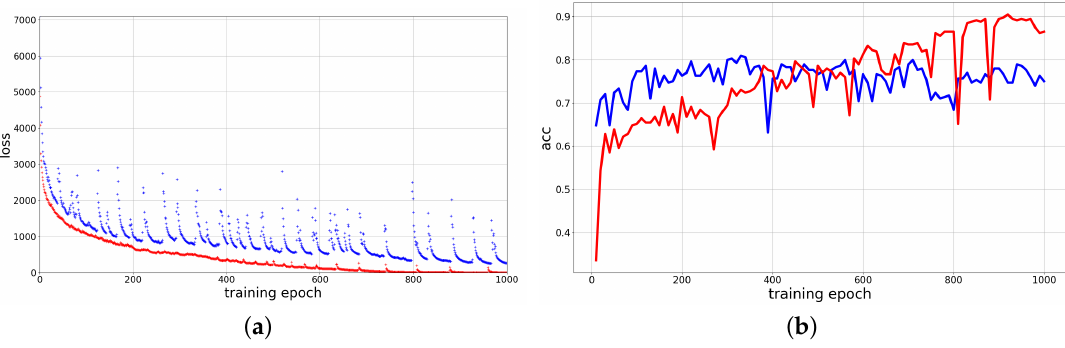
Figure 3. The comparison of the result of output of the last LSTM unit with softmax operation among the outputs of every LSTM unit: ( a ) comparison of loss; and ( b ) comparison of accurary. The red line represents our method, and blue line denotes softmax.